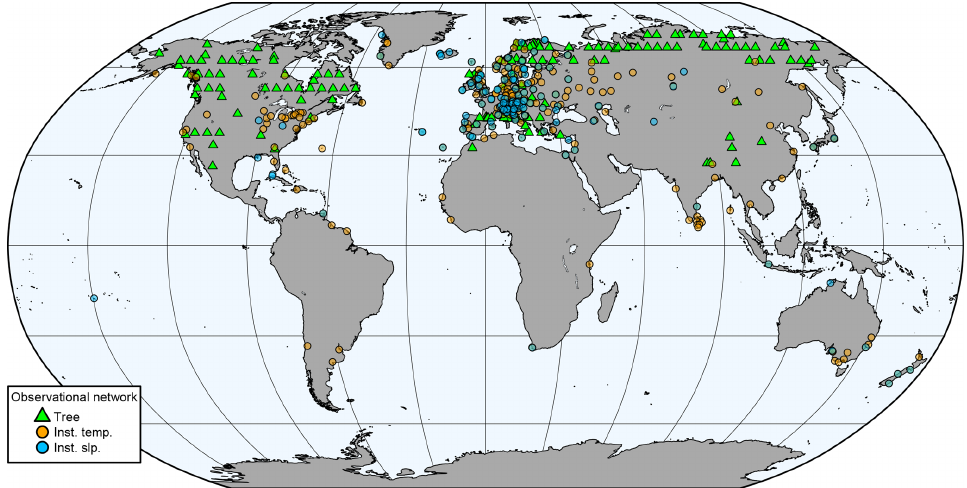
Figure 1. The observational network in 1904, before the quality check.